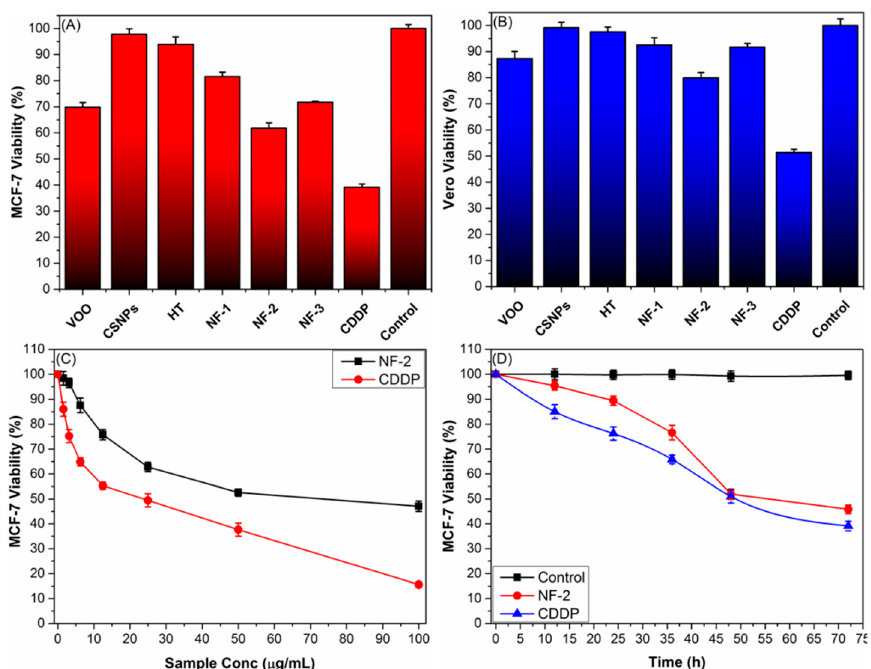
Figure 7. Inhibitory effects of a single dose (25 μ g/mL) of PBA-CSNPs-NFs on the proliferative activities of ( A ) MCF-7 cells and ( B ) Vero cells. ( C ) Dose-dependence cytotoxicity performance of the most active anticancer agent (NF-2) against MCF-7, as compared to the clinical anticancer drug (CDDP). ( D ) Time-dependence cytotoxicity performance of IC 50 dosages of NF-2 and CDDP on MCF-7 cells.